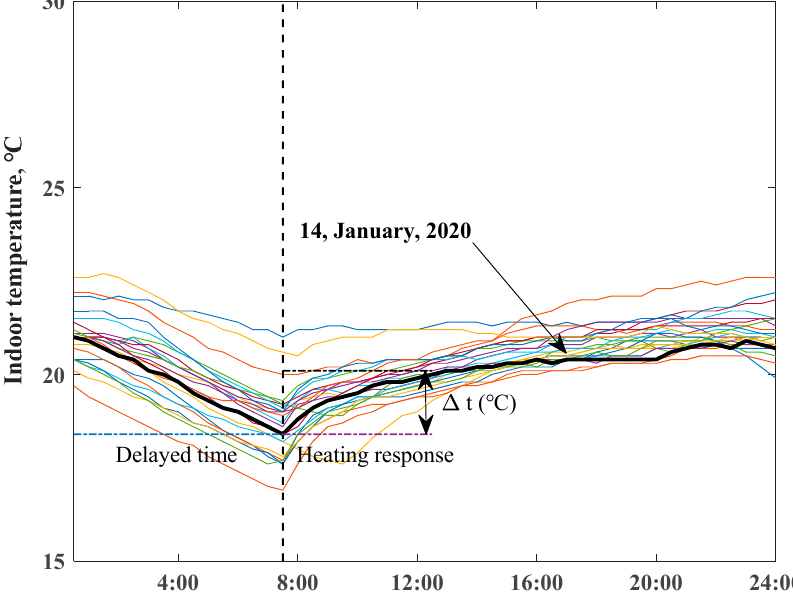
Figure 7. Daily indoor air temperature profiles of ZEH 2, bold black line presents the selected typical day.